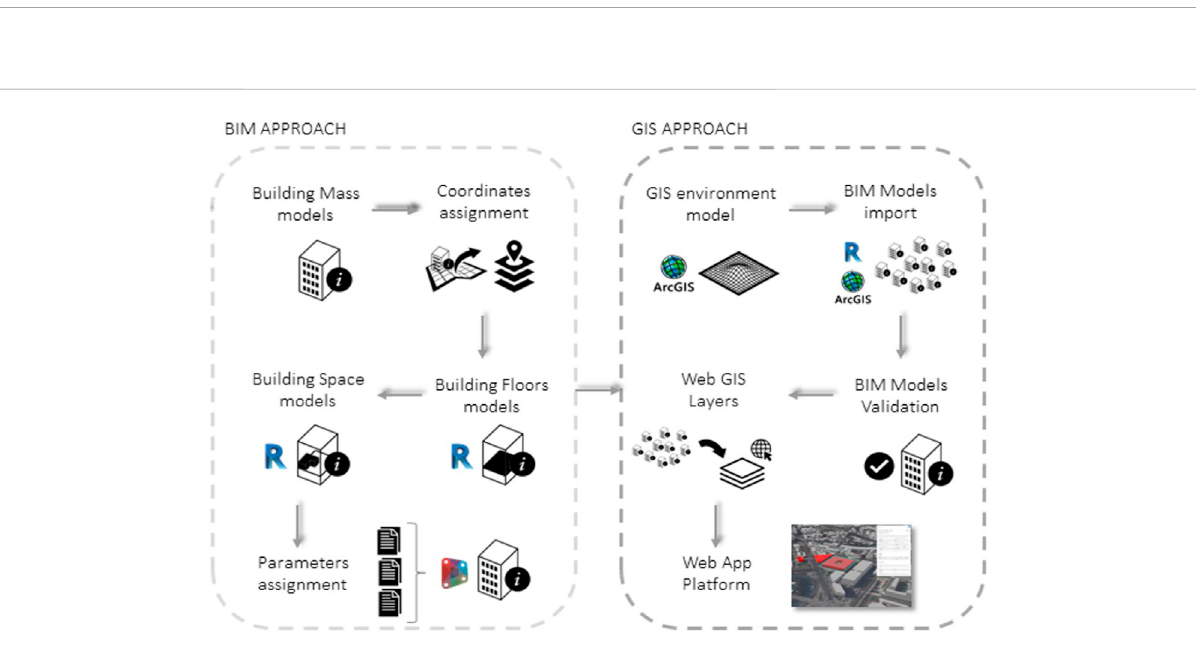
FIGURE 4 BIM-GIS integration work fl ow to develop the AMS